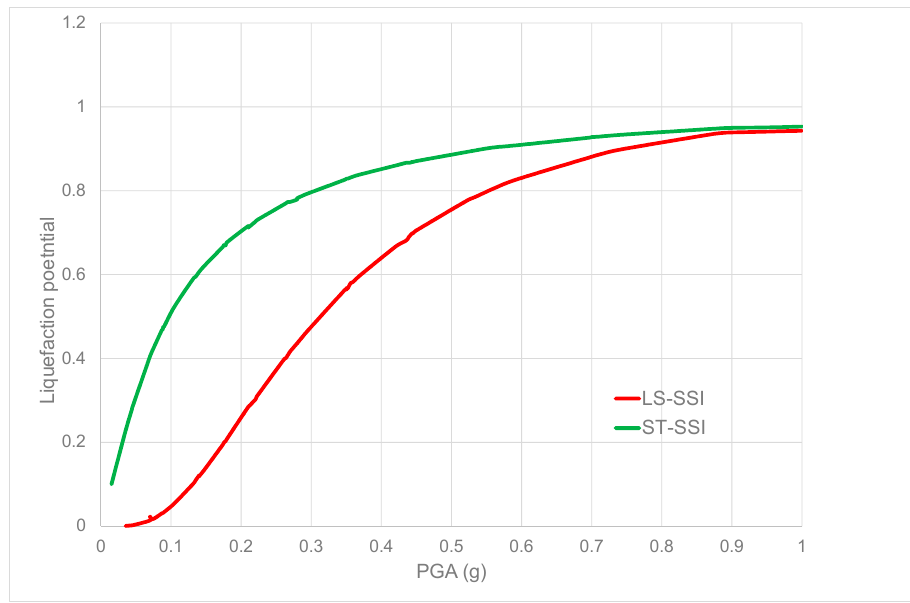
Figure 13. SSI: liquefaction potential (LP): lateral spread (LS) and settlement (ST) comparison.